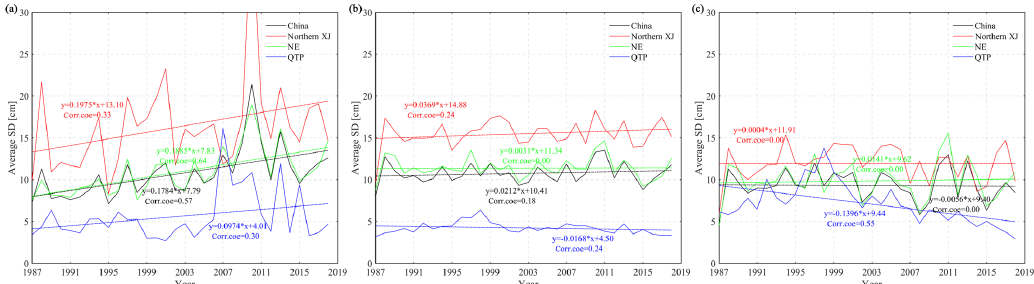
Figure 11. Trend analysis of snow depth based on (a) station observations, (b) RF estimates, and (c) WESTDC product in three stable snow cover areas of China. The correlation is statistically significant at the 0.05 level.